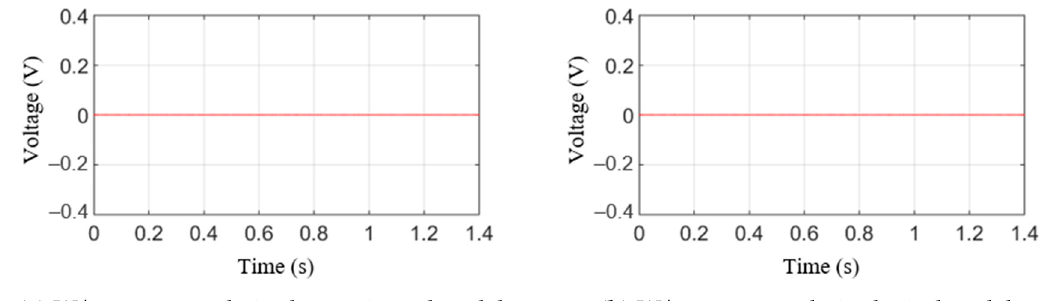
Figure 13. AE filtered signal without press process.